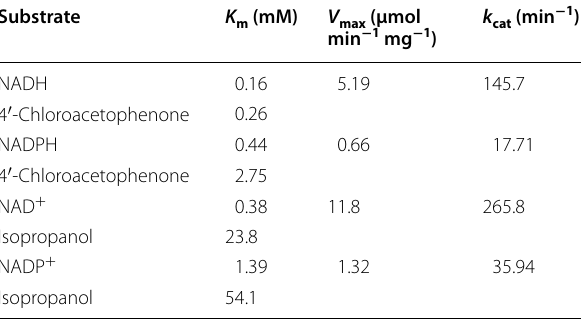
Table 5 Kinetic parameters of different substrates for the recombinant